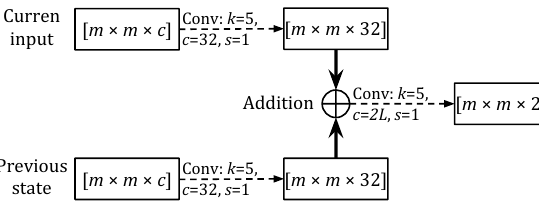
Figure 2. The trajectory generation network in a TrajGRU cell for tracking a subset of points between two steps (drawn from the implementation of Shi et al. [6]). The dotted arrows denote the convolution operations, where m is the cell’s state size, c is the cell’s number of channels, k is the convolution kernel size, s is the convolution stride size, and L is the number of neighboring points. In [6], the number of channels of the feature maps for fusing the two steps is fixed at 32. The output of this block has 2 L channels since it needs to estimate both the horizontal and vertical movements of each